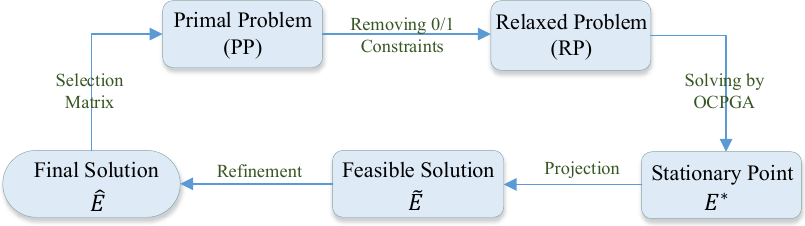
Figure 1. Working Flow of the OCPGA Based Method for Solving Problem ( PP